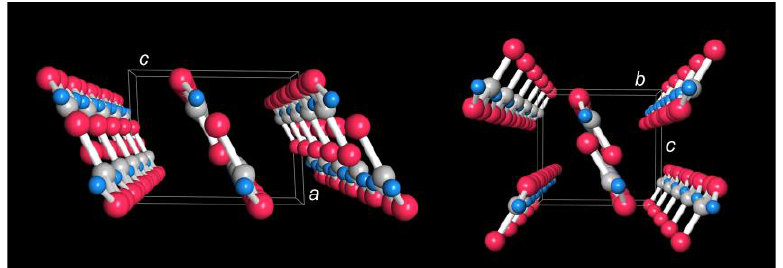
Figure 4. Possible molecular packings of carbonic acid. Packing in the experimental crystal structure on the left, showing stripes of H-bonded molecules running along the b direction (Table A3). On the right, we provide an alternative, energetically even lower polymorph found by density-functional theory in which the same stripes run along a but this time in a zig-zag stacking mode (Table A4).